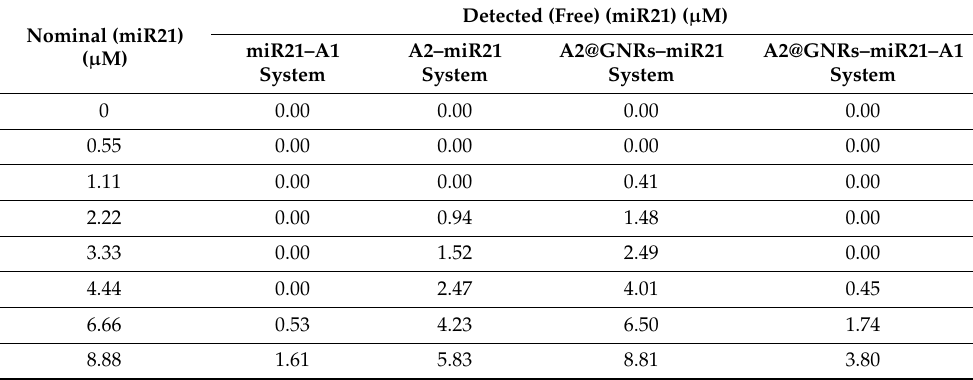
Table 1. Free miR21 concentration ( µ M) detected for: binary system miR21–A1,